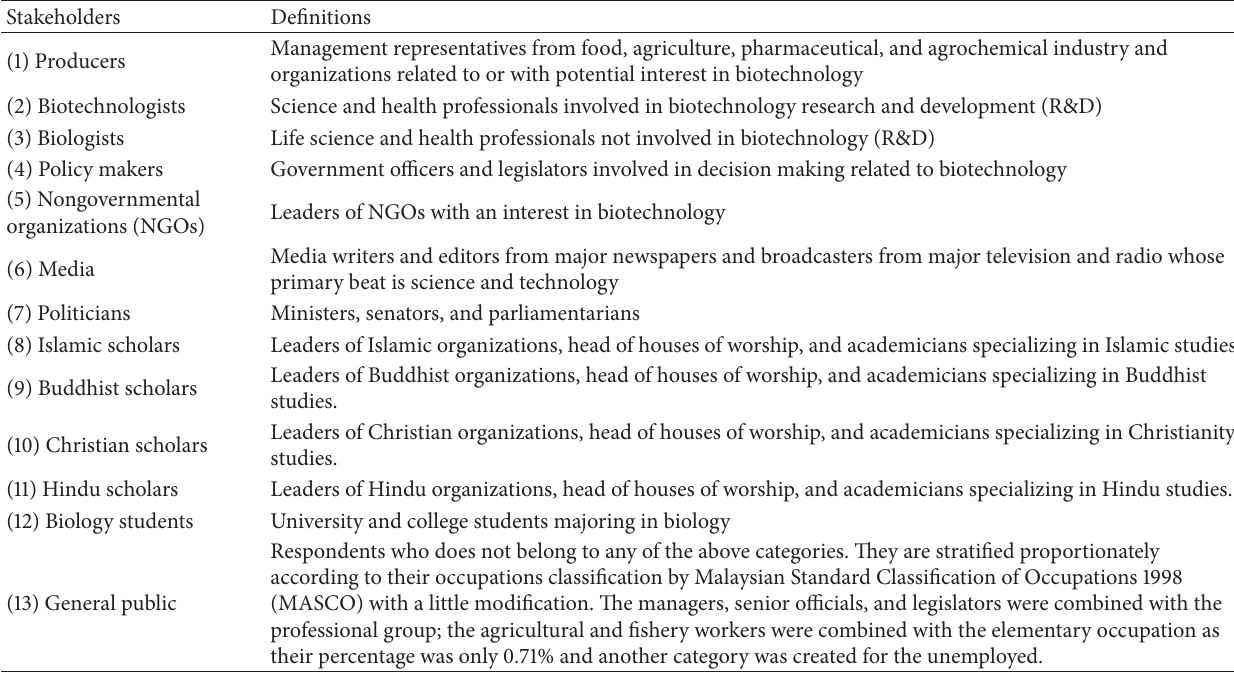
Table 1: Operational definitions of the